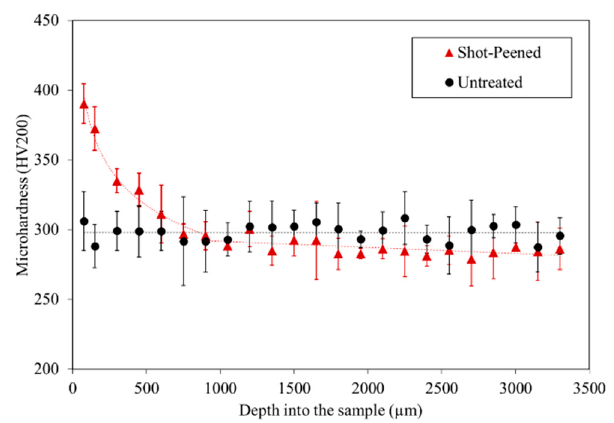
Figure 17. Average microhardness profile versus depth into the sample of a shot-peened PTA-SFFF Ti–TiB coupon (red triangle) in comparison with an untreated PTA-SFFF Ti–TiB coupon (black circle). Image reproduced with permission from DiCecco et al. [29] (Copyright© 2021 SpringerNature).